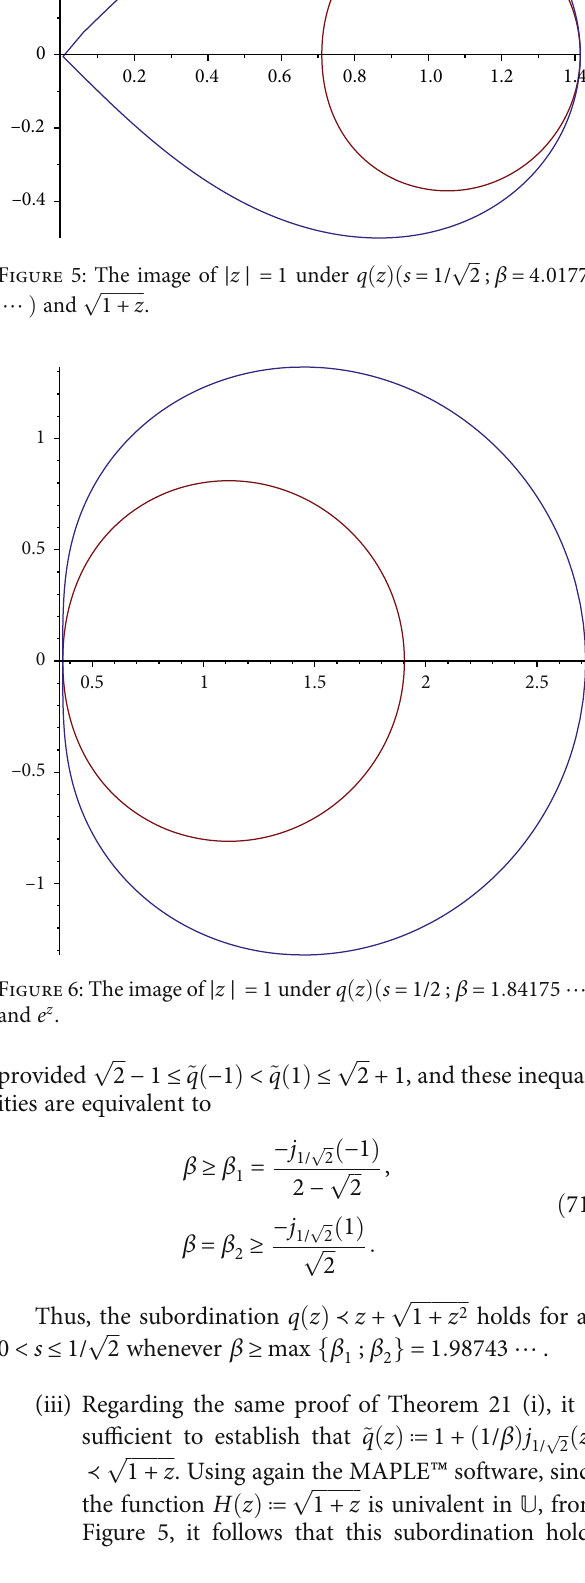
ffiffiffi p 2 ; β = 4 : 01776